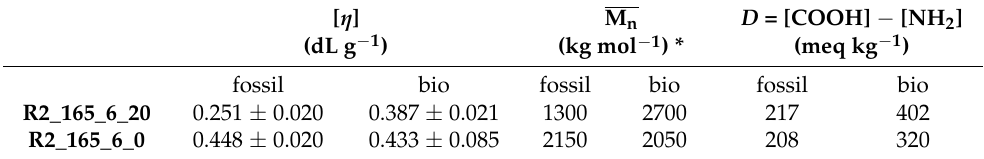
Table 9. Effect of nitrogen flow rate: molecular size and end-groups imbalance of DSSP products.